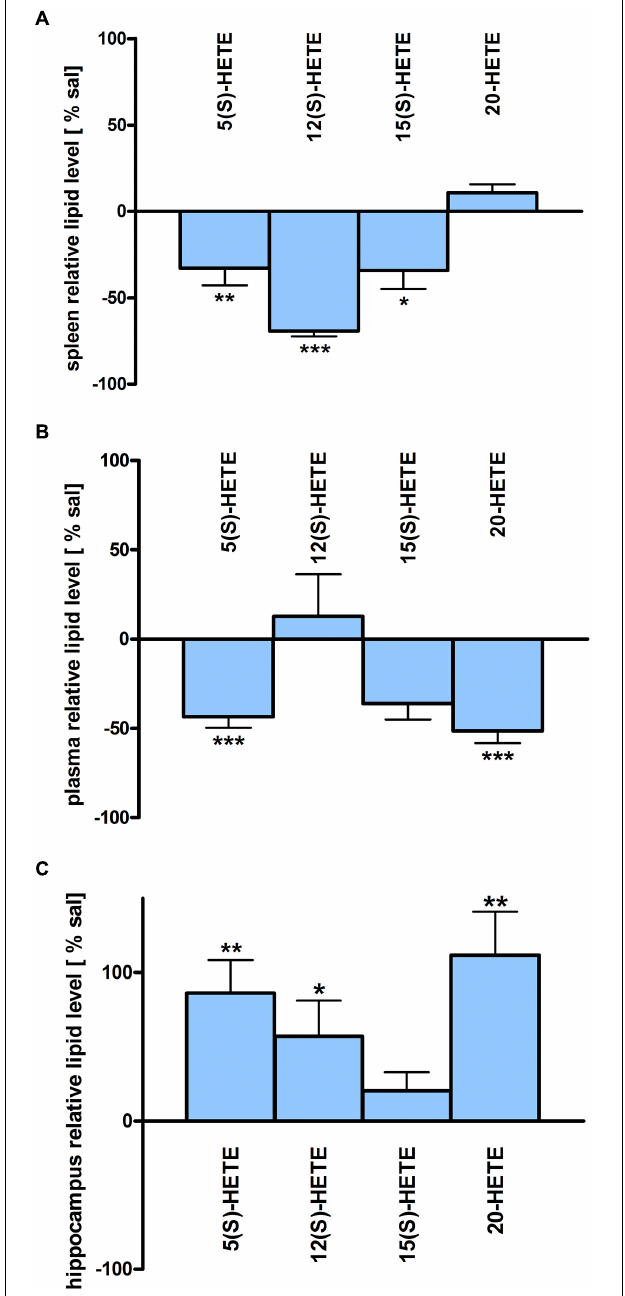
FIGURE 5 | HETE lipid levels in brain and periphery after PEA treatment: relative HETE concentrations (normalized to ml plasma/tissue weight) after PEA treatment as percentage of saline treated mice are shown and presented as mean value ± SEM. (A) Spleen: HETE alterations with sub-chronic PEA treatment and unchanged HETE levels in spleen. Only significant reductions of HETE levels can be found in spleen. (B) Plasma HETE alterations with sub-chronic PEA treatment and unchanged HETE levels in plasma. Only significant reductions of HETE levels can be found in plasma. (C) Hippocampus: HETE alterations with sub chronic PEA treatment and unchanged HETE levels in hippocampus. Only significant increments of HETE levels can be found in hippocampus. Data were considered significant at a p -value < 0.05, e.g., ∗∗∗ p < 0.001, ∗∗ p = 0.001 to 0.01; ∗ p = 0.01 to 0.05.